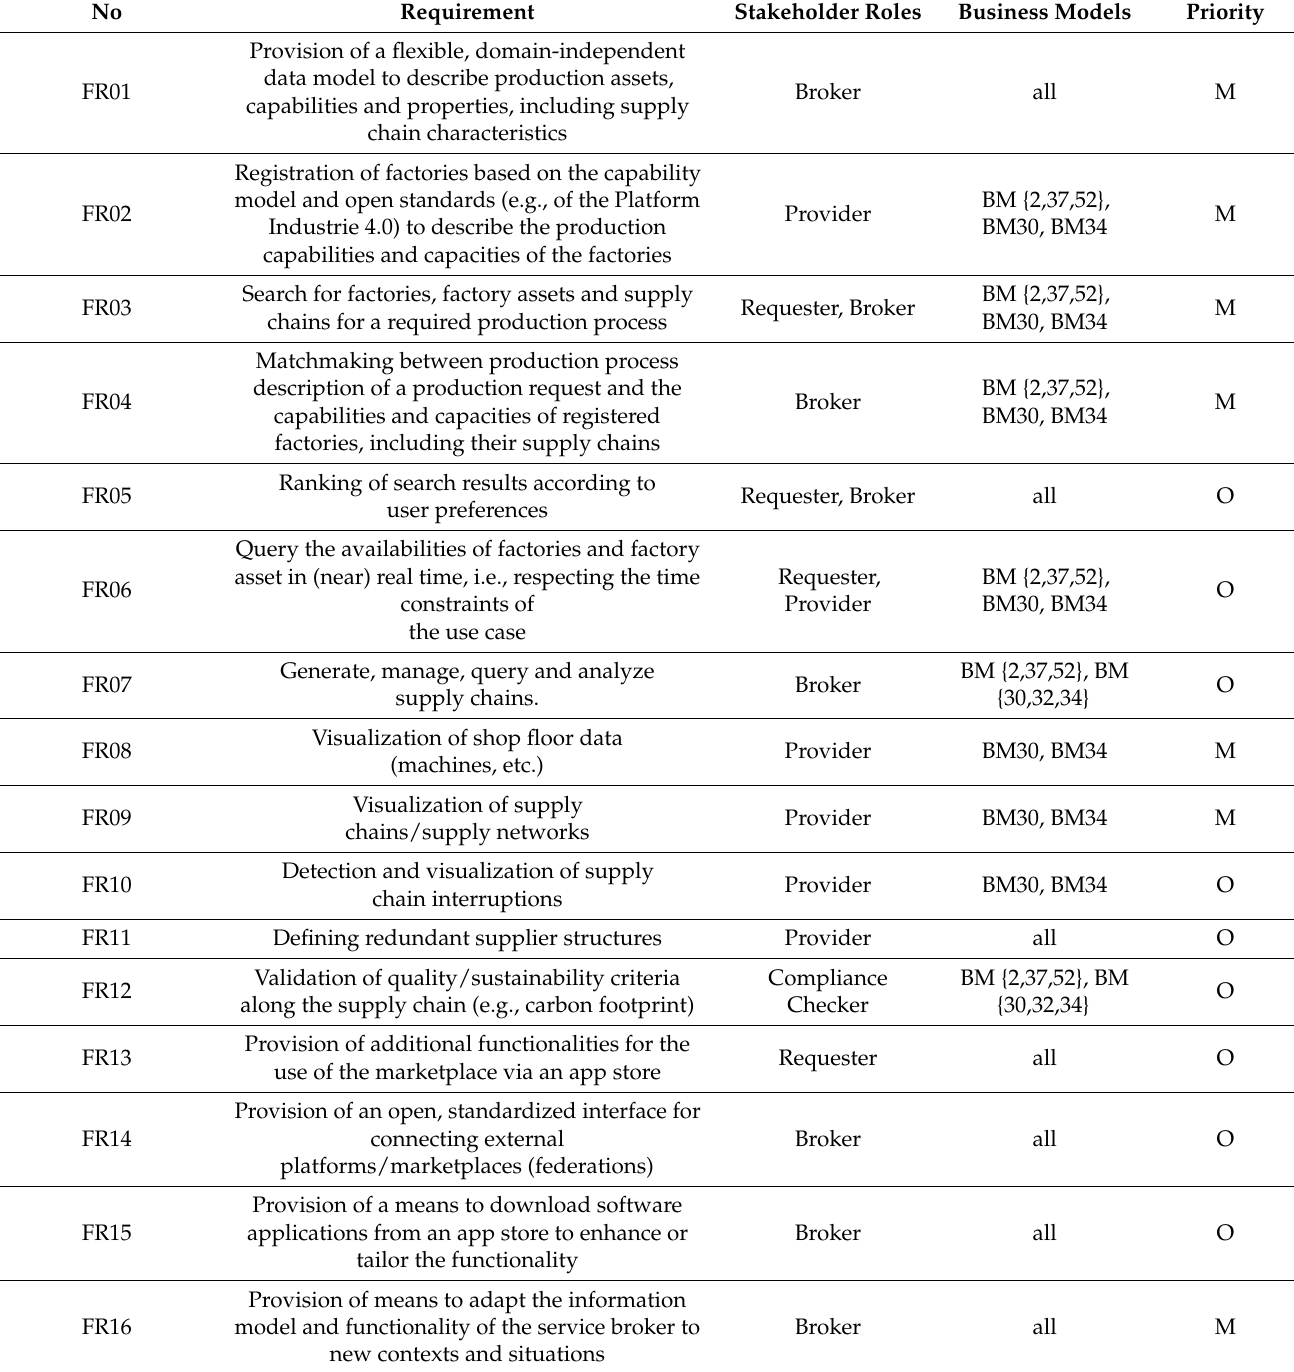
Table 2. Functional requirements (M = mandatory, O =